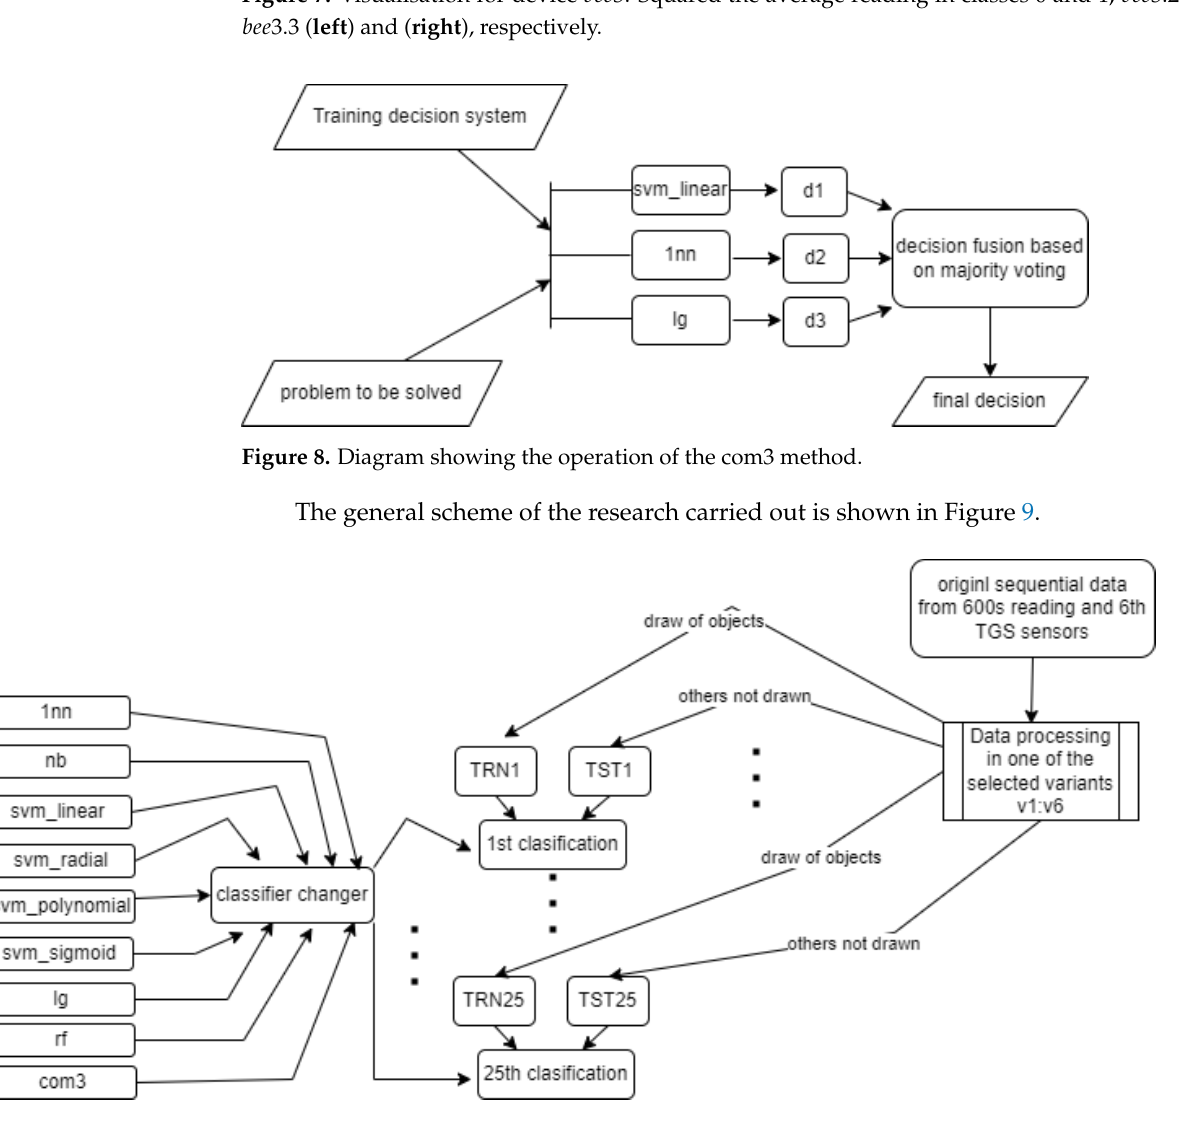
Figure 9. The general scheme of our